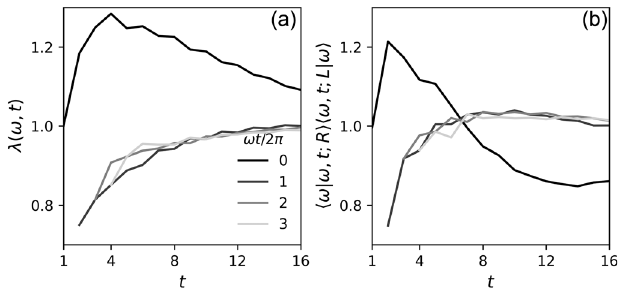
¯ T ð t Þ FIG. 34. (a) Eigenvalues of and (b) overlaps of leading eigenvectors with paired states, as in Fig. 15, here with Heisen- berg interactions and J ¼ 1 = 4 .